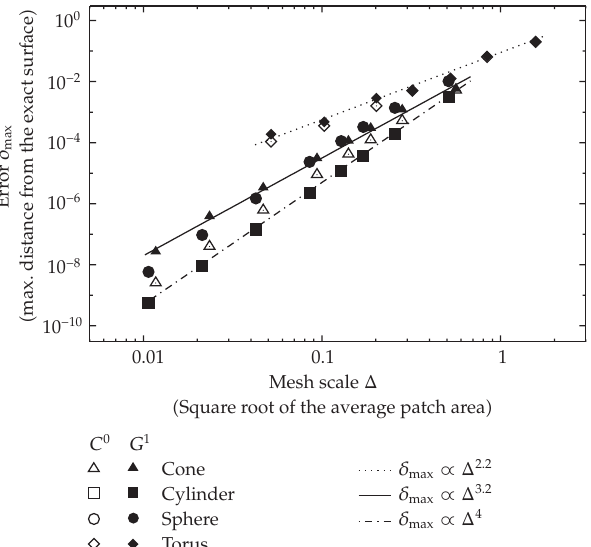
Figure 5: Interpolation error of the Nagata patches as a function of the mesh